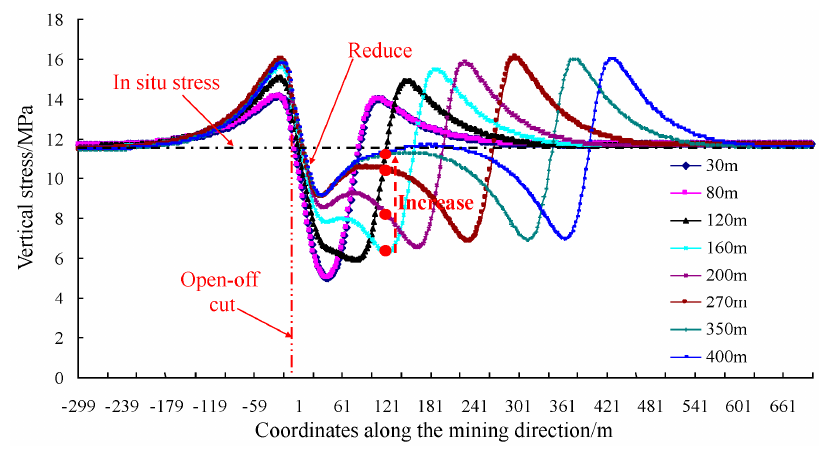
Figure 3. Vertical-stress curve for the No. 3–5 coal seam in the mining of the No. 4 seam.